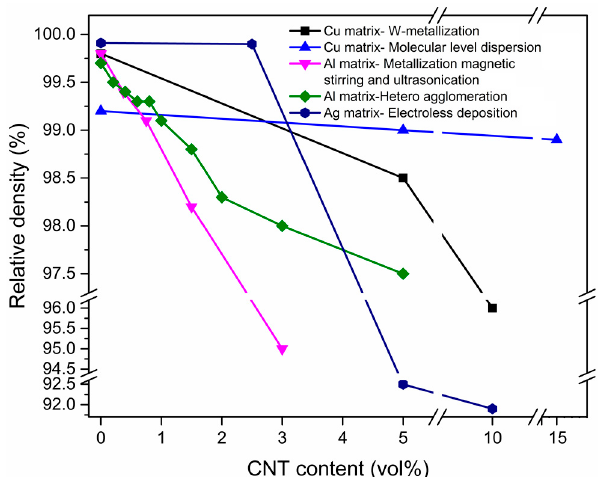
Figure 11. The relative density of some SPSed CNT-metal matrix nanocomposites fabricated by different dispersion methods [16,48,49,96,104].